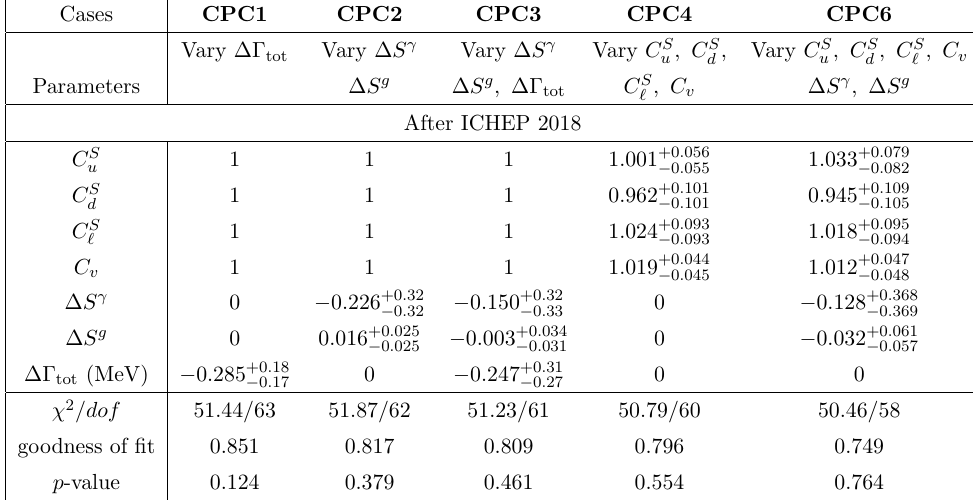
Table 5 . CPC : the best-(cid:12)tted values in various CP conserving (cid:12)ts and the corresponding chi- square per degree of freedom and goodness of (cid:12)t. The p -value for each (cid:12)t hypothesis against the SM null hypothesis is also shown. For the SM, we obtain (cid:31) 2 = 53 : 81, (cid:31) 2 =dof = 53 : 81 = 64, and so the goodness of (cid:12)t = 0 : 814.